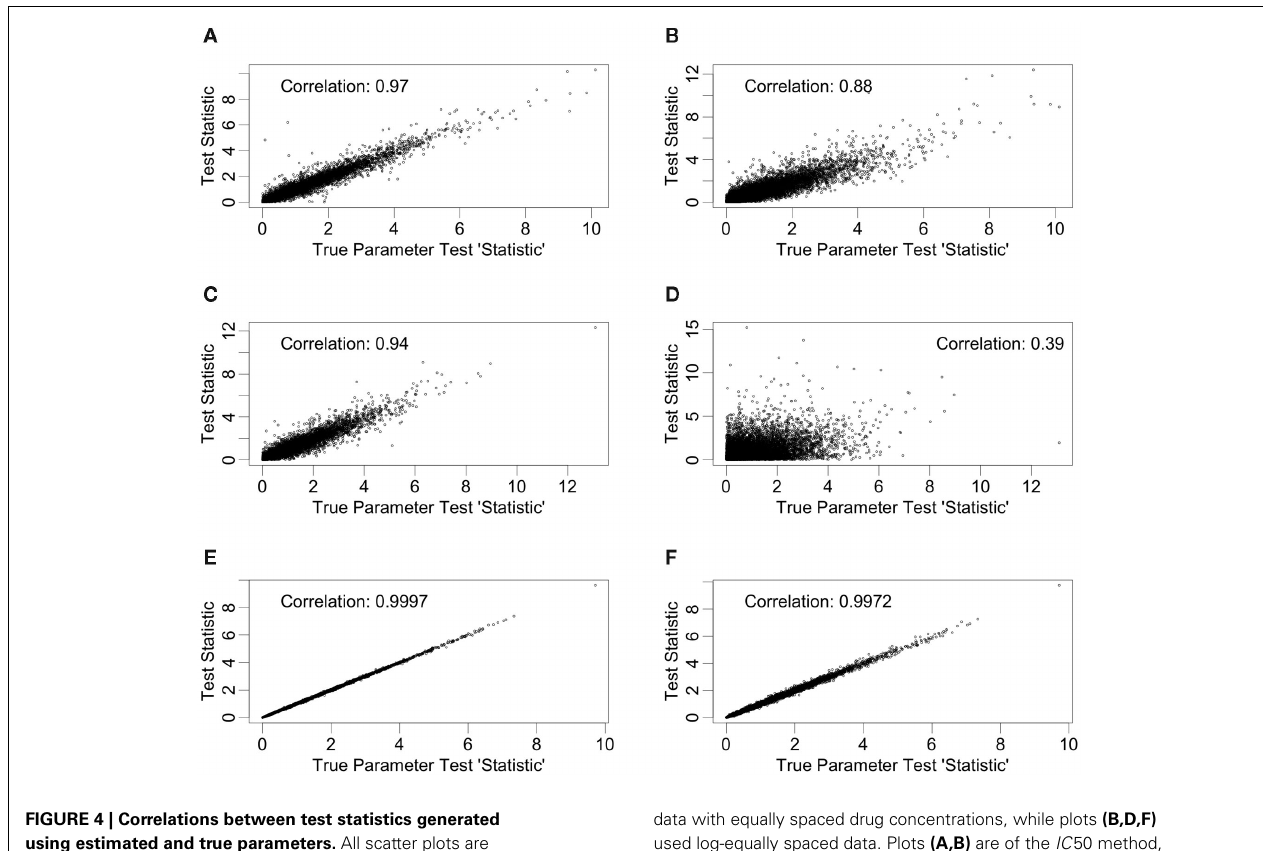
FIGURE 4 | Correlations between test statistics generated using estimated and true parameters. All scatter plots are between test statistics generated under the null hypothesis and a MAF of 0.25.The plots (A,C,E) are of statistics generated from